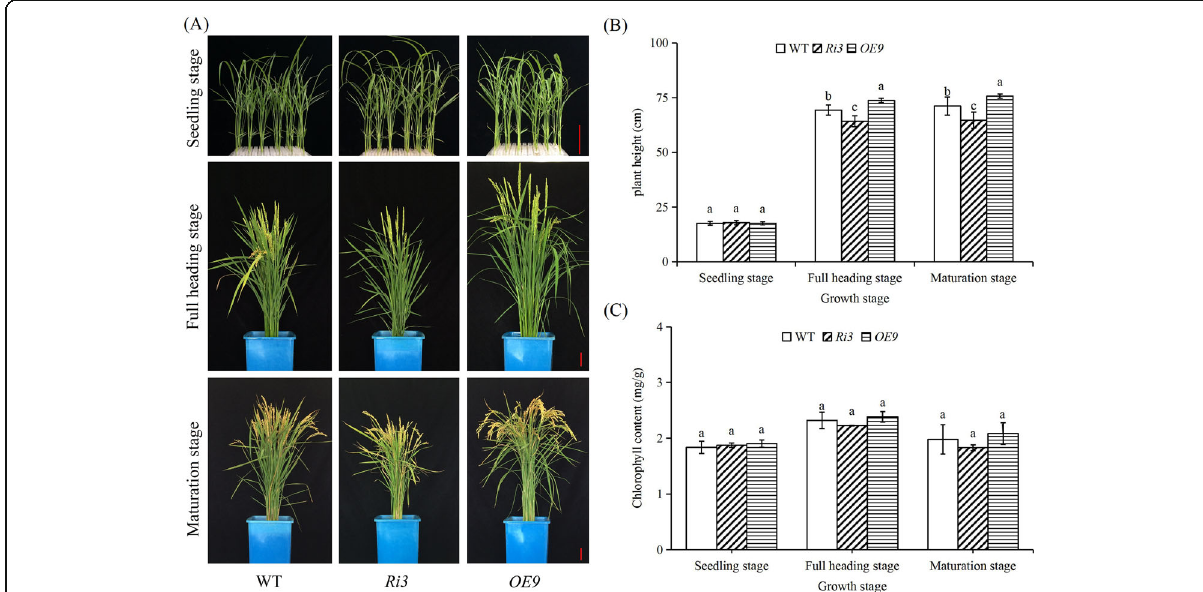
Fig. 3 Plant height and chlorophyll content differences between wild-type and transgenic plants at different growth stages. a Appearance, b plant height, and c chlorophyll content of WT, Ri3 and OE9 at different growth stages. The seedling, full heading and maturation stages of rice were grown to 14d, 60d, and 90d after sowing, respectively. Values are means±SEM, n = 5( b ) and 3( c ). Significant differences ( P < 0.05) are denoted by different lowercase